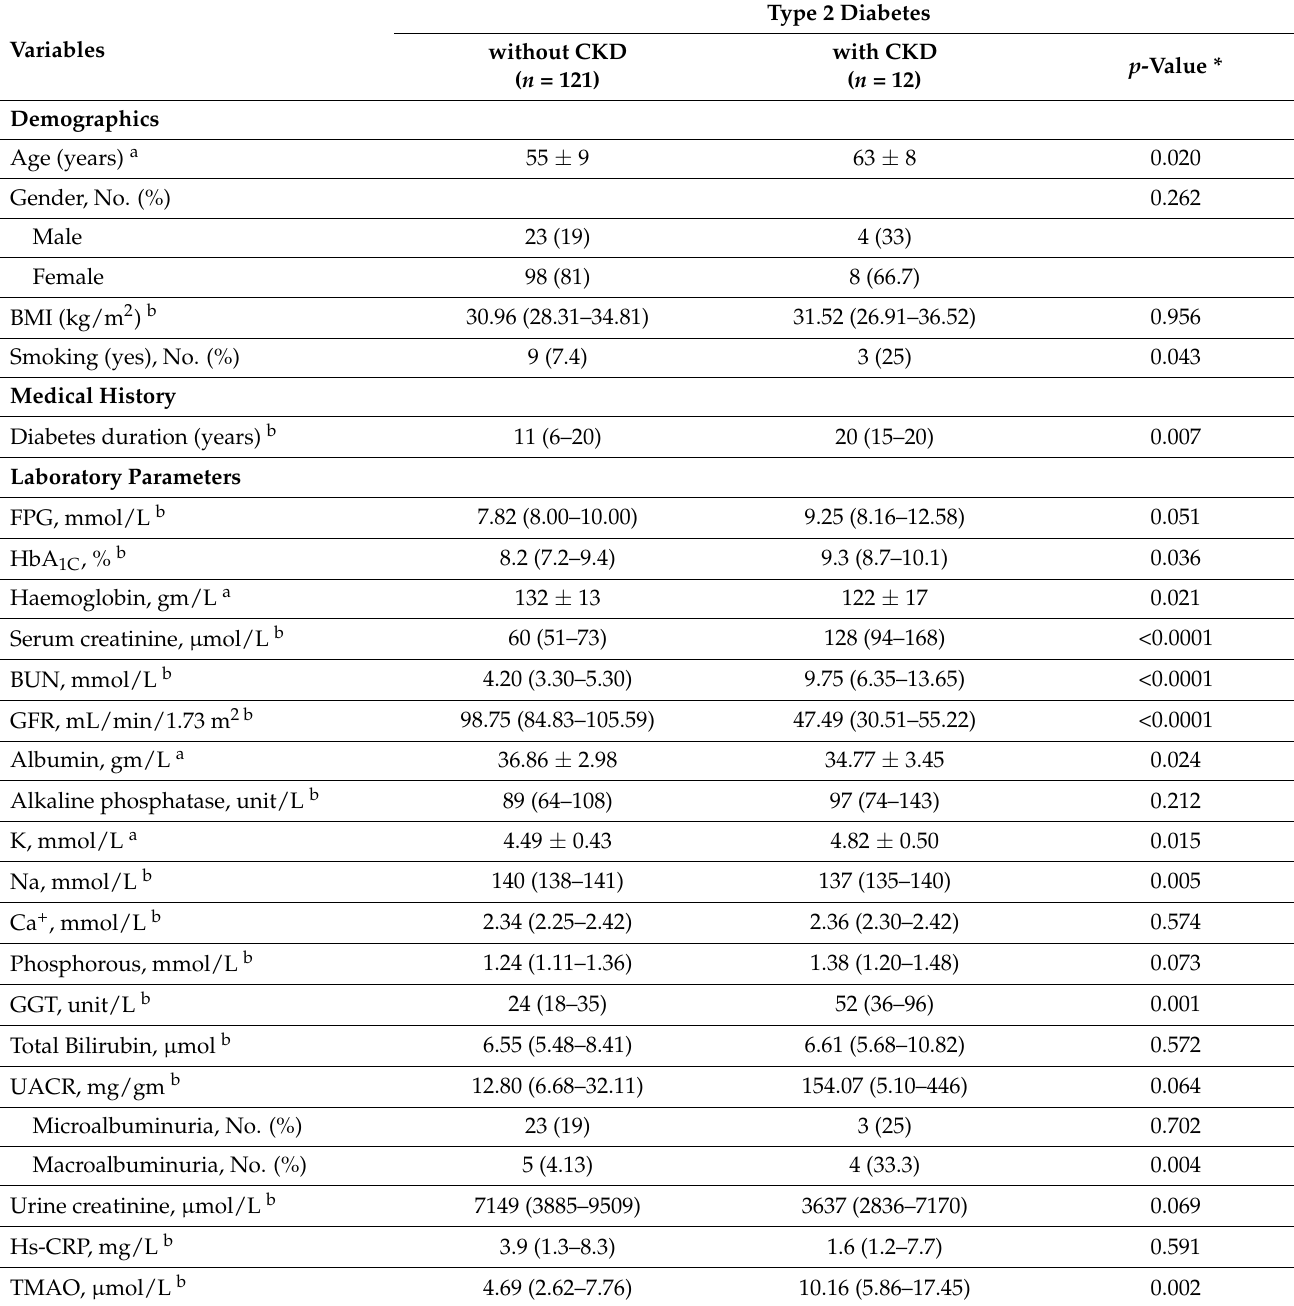
Table 1. Participant characteristics and metabolic parameters of patients with T2D, with or without